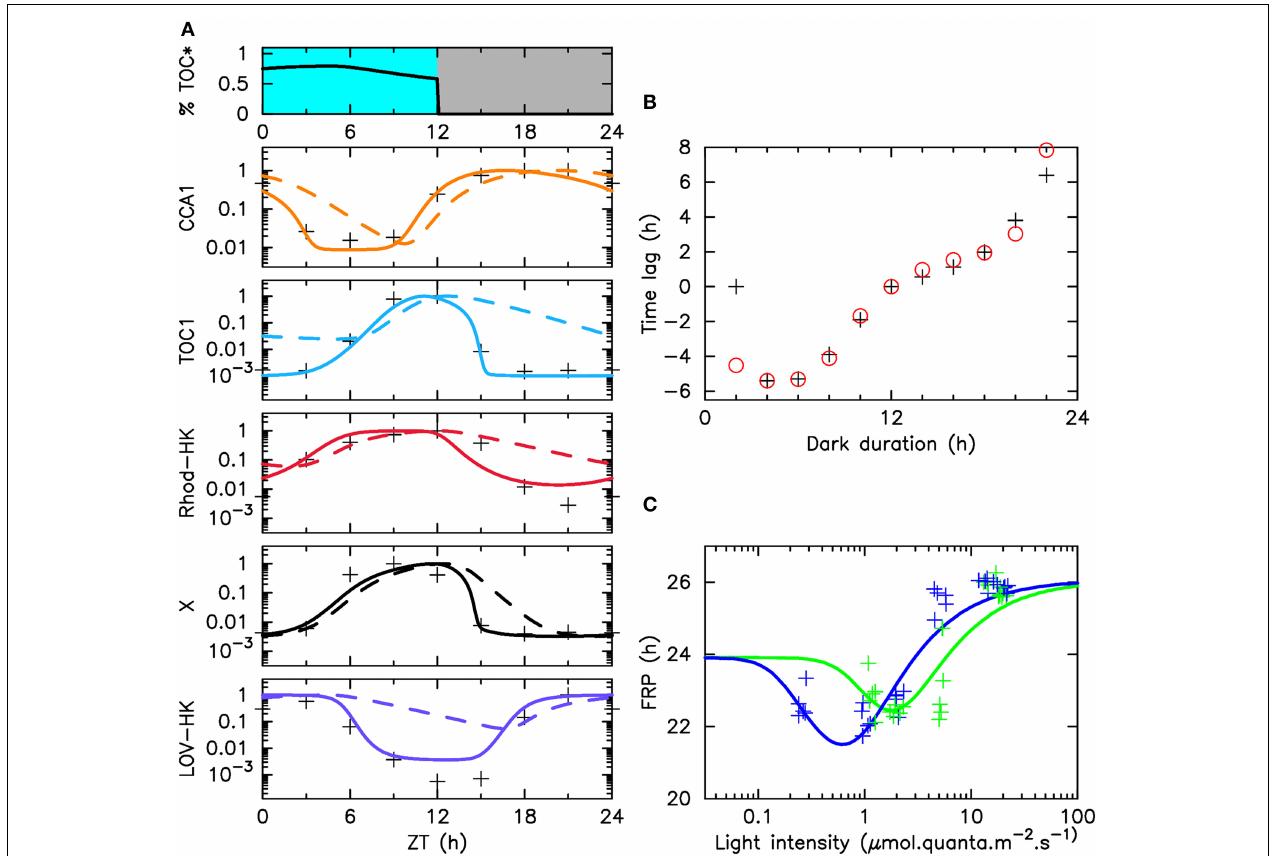
FIGURE 2 | Adjustment of the model to various experimental data sets. (A) The top panel displays the illumination pattern and the fraction of phosphorylated TOC1. The other panels display, for each molecular actor: the experimental mRNA time profiles under LD 12:12 entrainment (crosses), numerical mRNA time profiles (solid lines) and protein time profiles (dashed lines), in logarithmic scale. (B) Phase shifts in resetting experiments as a function of the duration of the last dark period. Phase shifts are obtained as the difference in asymptotic phase with respect to the experiment where this